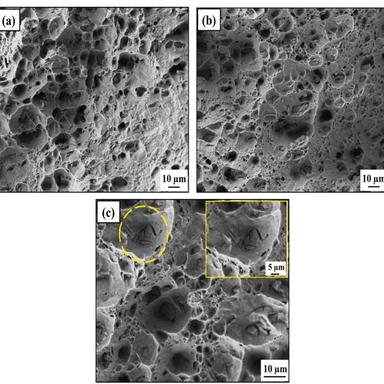
SEM fractographs showing the fracture surface of (a) Base, (b) WOR_3 and (c) WR_3 composite materials subjected to dynamic tensile test.